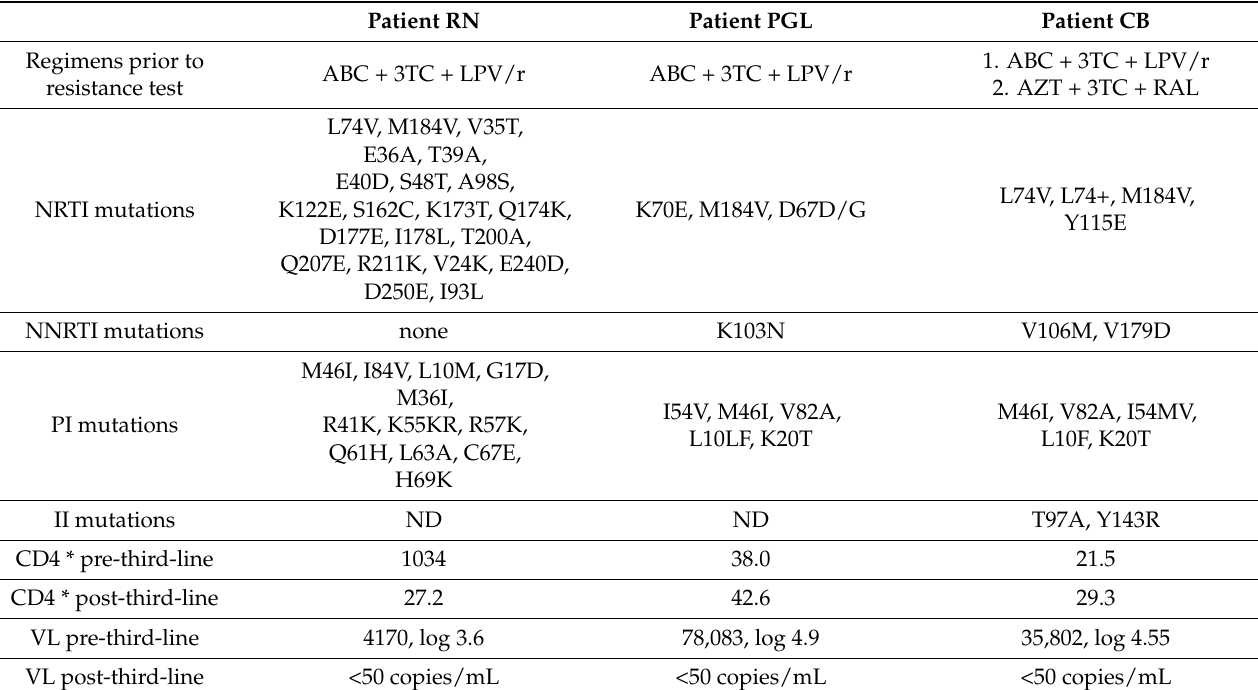
Table 1. Prior regimens, mutations, and pre- and post-third-line CD4 and viral load. Patient